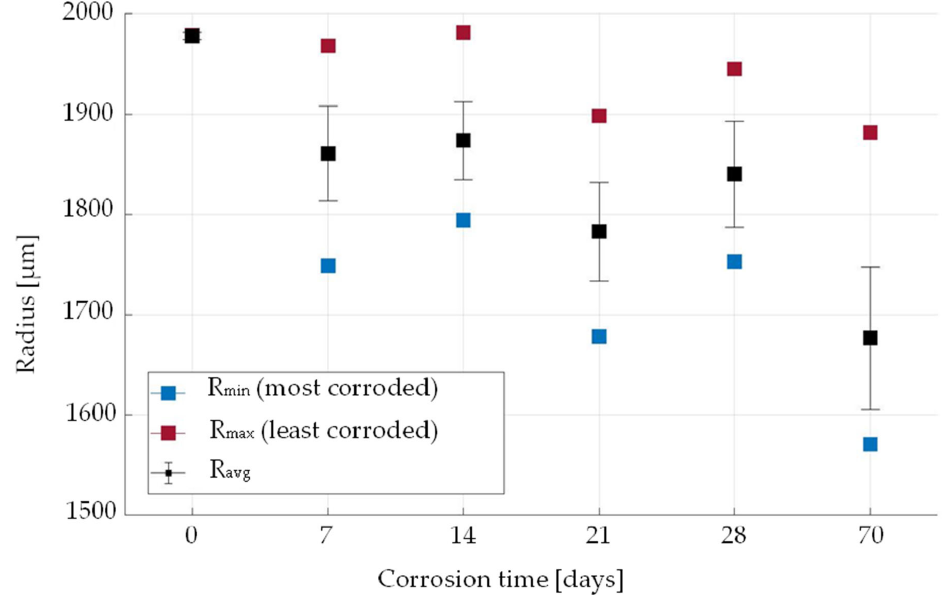
Figure 3. Image analysis of the cross sections. R min : the radius at the most corroded spot in blue, R max : the radius at the least corroded spot in red, and the average remaining radius R avg of the specimen in black including the standard deviation.